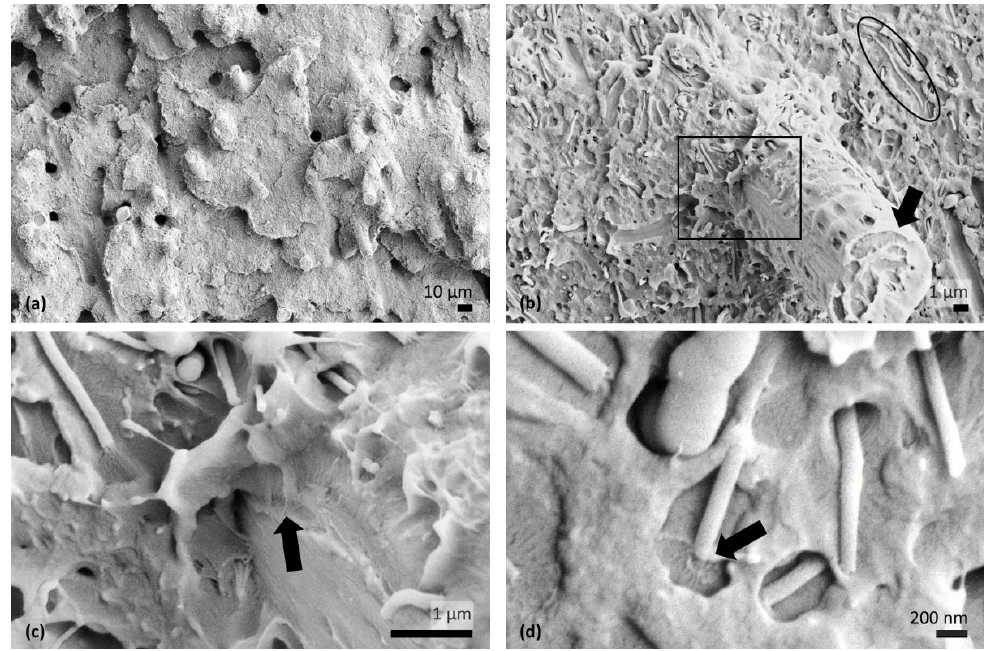
Figure 4. SEM micrographs showing the morphology of 20CF–2.5CNF-PEEK ( a ) at low